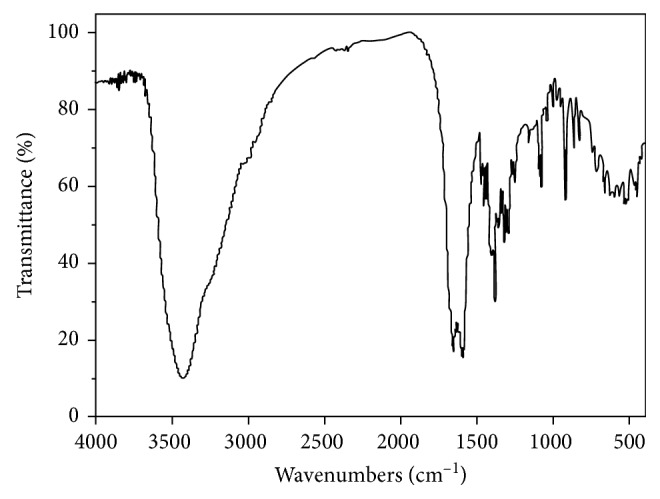
FTIR spectrum of the title complex.